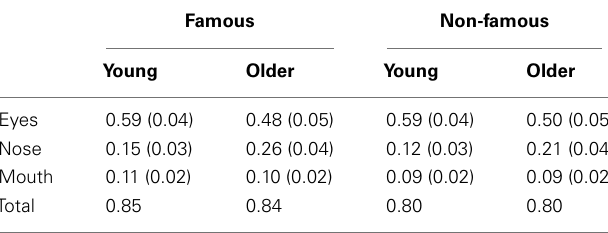
Table 1 |The proportion of fixations made to the eyes, nose, and mouth of famous and non-famous faces across exposures.